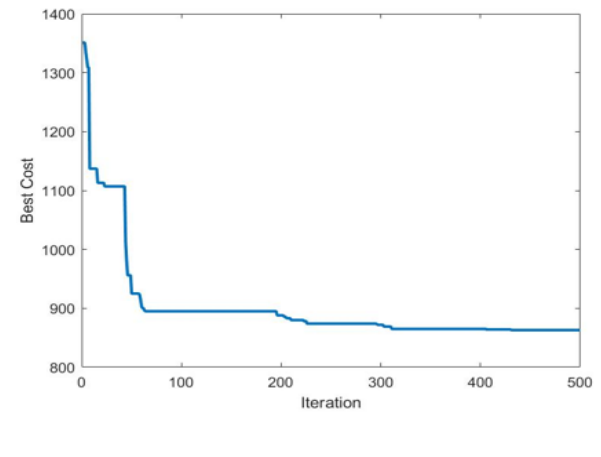
Fig. 4. The results of the SA algorithm for 15 and 20